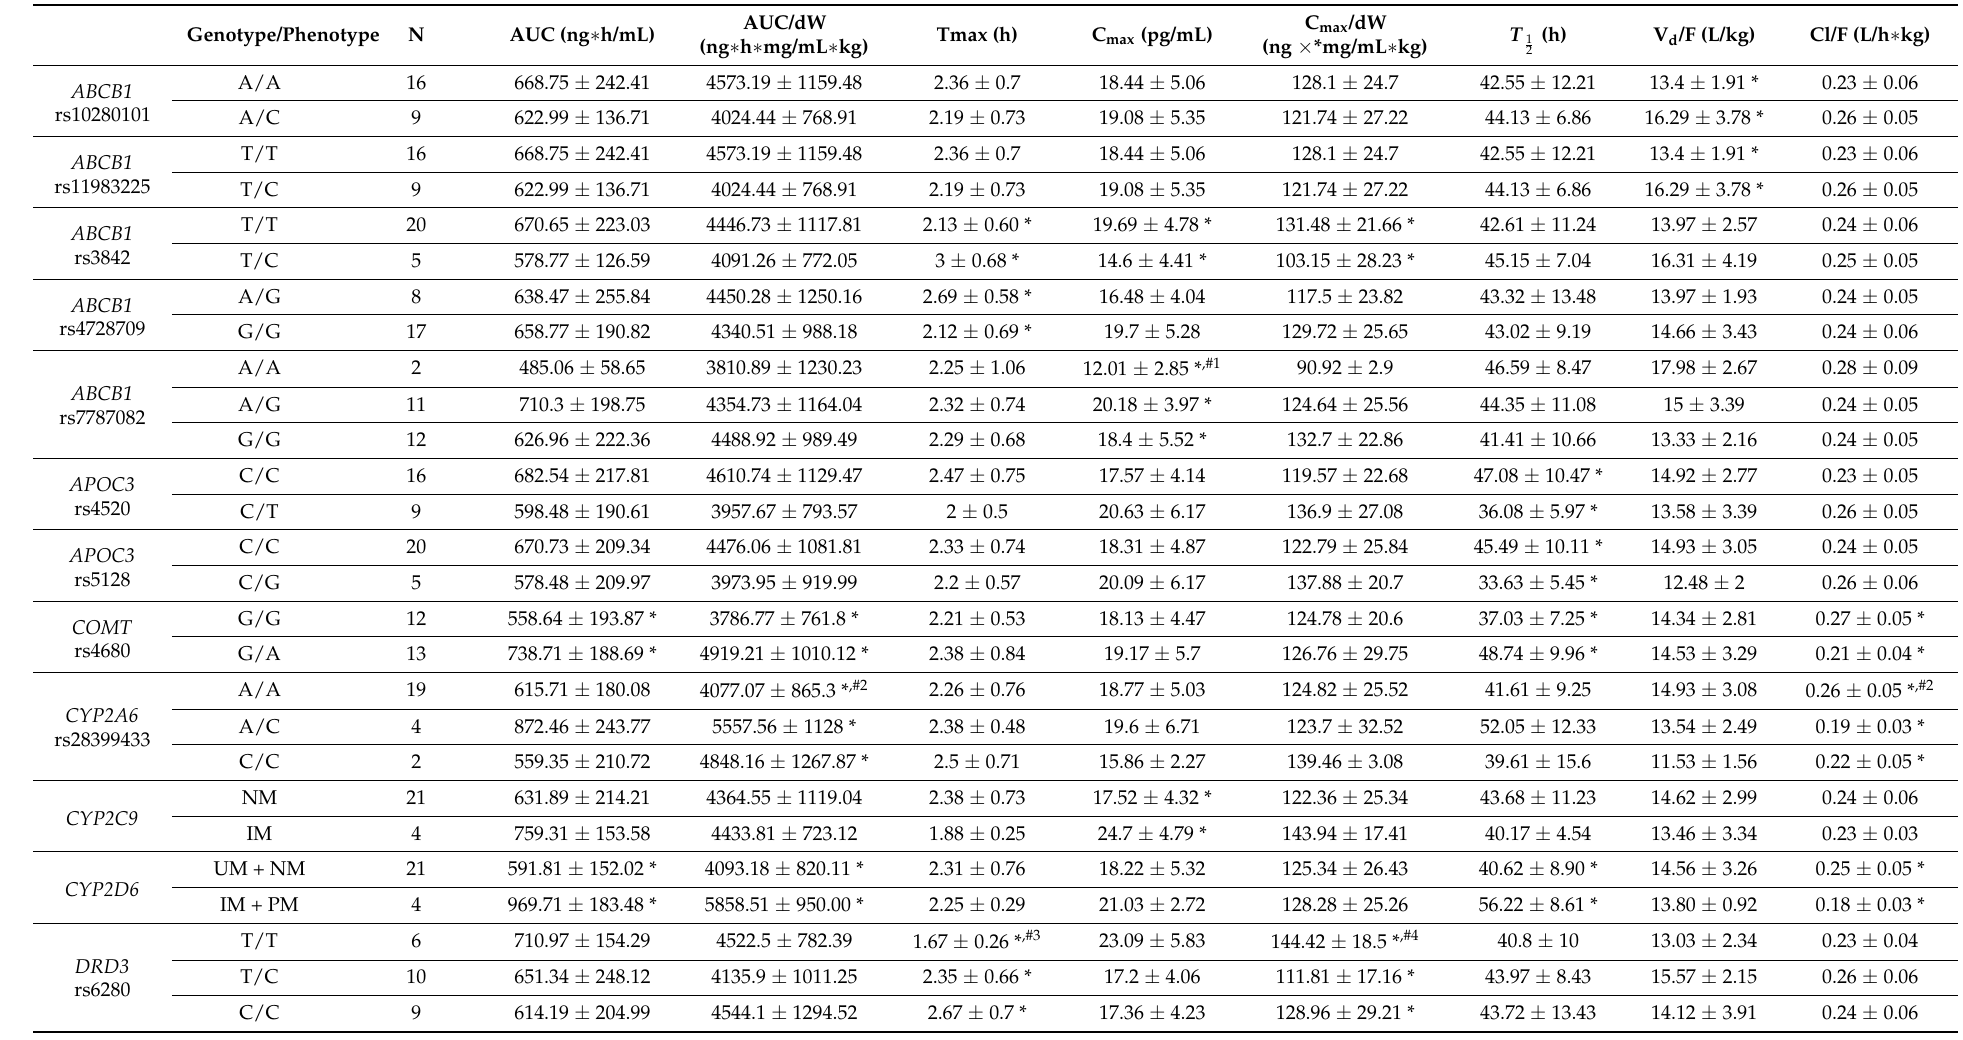
Table 4. Donepezil pharmacokinetic parameters based on genotypes or phenotypes with significant variability in the univariate